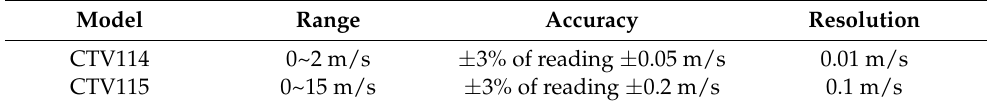
Table 1. Specification and range of velocity-measuring instrument.